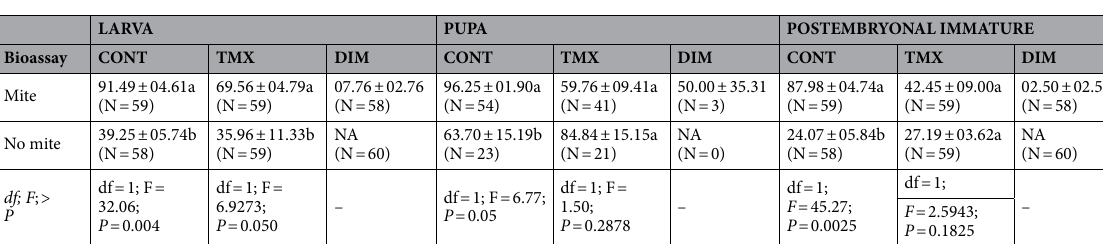
Table 1. Summary of Scaptotrigona postica survivorship in each development phase. Survivorship (%) (Mean ± SE) of bees in each development phase (larva, pupa and postembryonal immature) in the presence (Mite) and in the absence (No mite) of mites on diets treated with thiamethoxam, dimethoate and untreated (respectively TMX, DIM and CONT bioassays). Means were contrasted by the F test from a generalized linear model of the quasibinomial type (α = 005). N Initial number of individuals, NA No applicable.